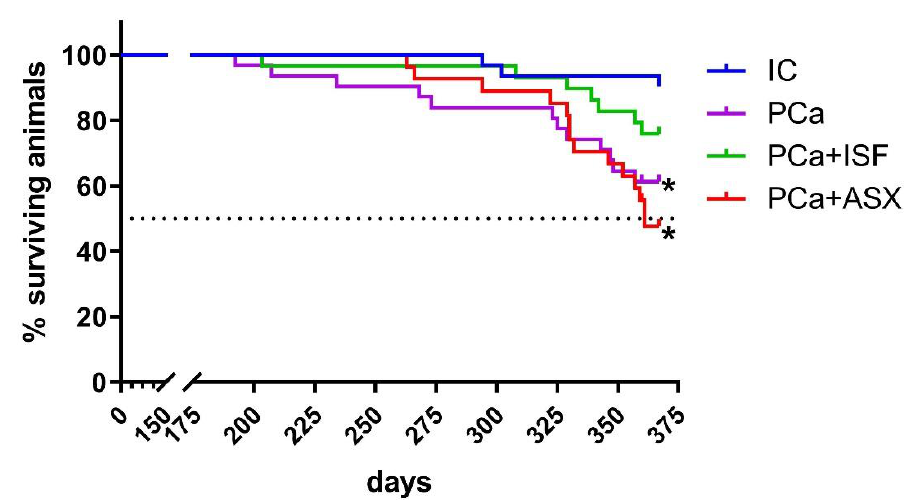
Figure 1. Survival curves of rats with (PCa) and without (IC) induced prostate cancer. ISF—extract of Pueraria lobata roots rich in isoflavones. ASX— Phaffia rhodozyma extract rich in astaxanthin. *— p < 0.05 vs. IC (log-rank test). Table 1. Body weight and organ/body weight ratio of rats.